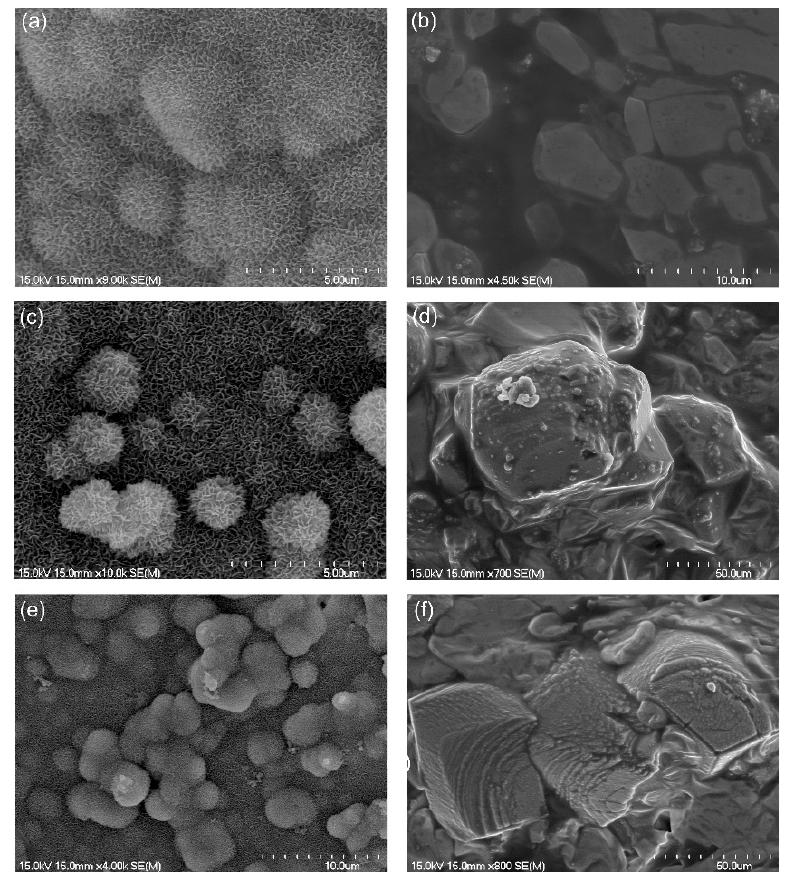
Figure 7. Scanning electron micrograph: composite with 0.1% wt / wt urease submerged in ( a ) low concentration of calcium chloride and urea and ( b ) standard concentration of calcium chloride and urea; composite with 0.3% wt / wt urease submerged in ( c ) low concentration of calcium chloride and urea and ( d ) standard concentration of calcium chloride and urea; composite with 0.5% wt / wt urease submerged in ( e ) low concentration of calcium chloride and urea and ( f ) standard concentration of calcium chloride and urea.